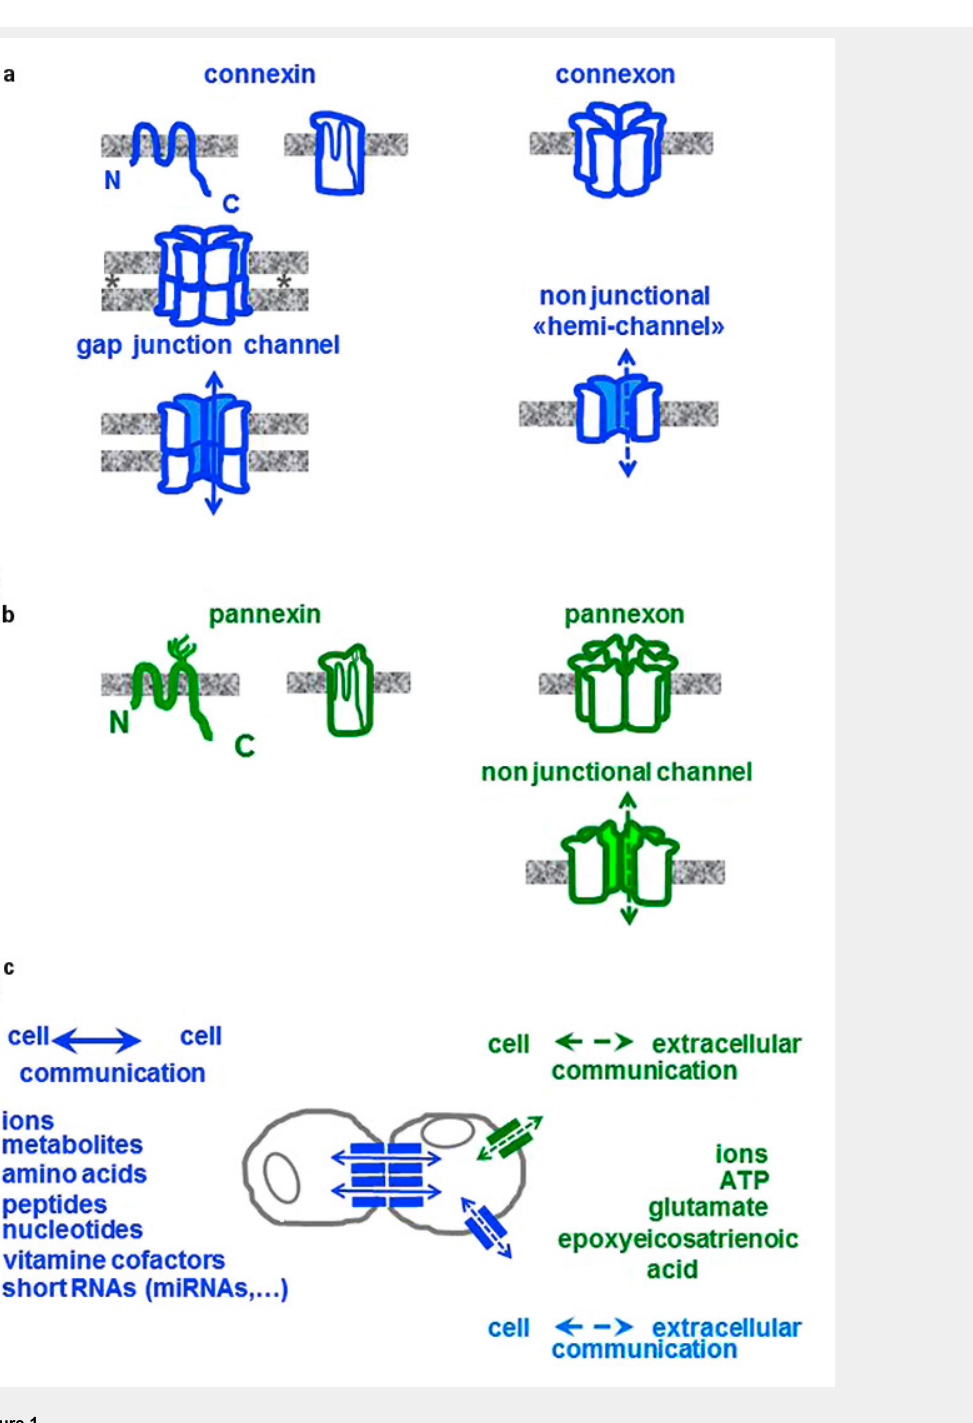
Figure 1 Connexins and pannexins. (a) All connexins (blue) feature 4 domains, which cross the cell membrane (grey) and are connected by one cytoplasmic loop and two extracellular loops. Six connexins oligomerise to form tubular structures, referred to as connexons. Connexons of one cell usually pair with the connexons of an adjacent cell to bridge the intercellular space (asterisks), thus establishing a cell-to-cell, or gap junctional channel. Infrequently, connexons may also be inserted in a non-junctional region of the cell membrane to form “hemi-channels”, which connect cytoplasms to the extracellular medium. (b ) Pannexins (green) show a membrane topography similar to that of connexins, and also oligomerise to form pannexons, similar to connexons. However, pannexins feature glycosylated residues on the second extracellular loop that prevent the close apposition of two cells, which is required to form intercellular channels. Hence, pannexons only form non-junctional channels. (c) Connexins mediate cell-to-cell communications by allowing for a bidirectional, diffusional exchange of several cytosolic molecules, including those listed (blue). Pannexins mediate the efflux of cytosolic molecules (green), thus allowing for paracrine signalling, or the uptake by the cells of molecules present in the extracellular